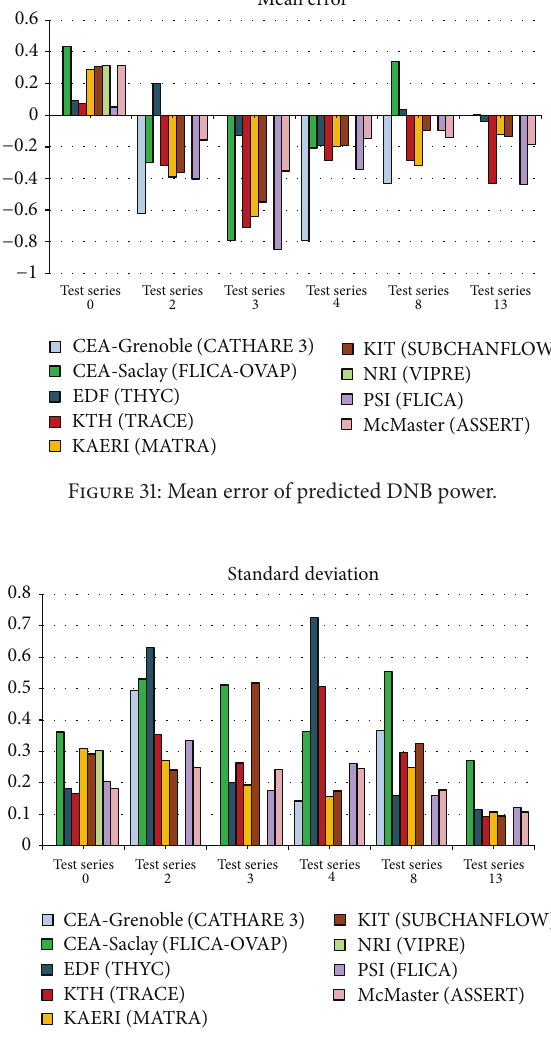
Figure 32: Standard deviation of predicted DNB power.